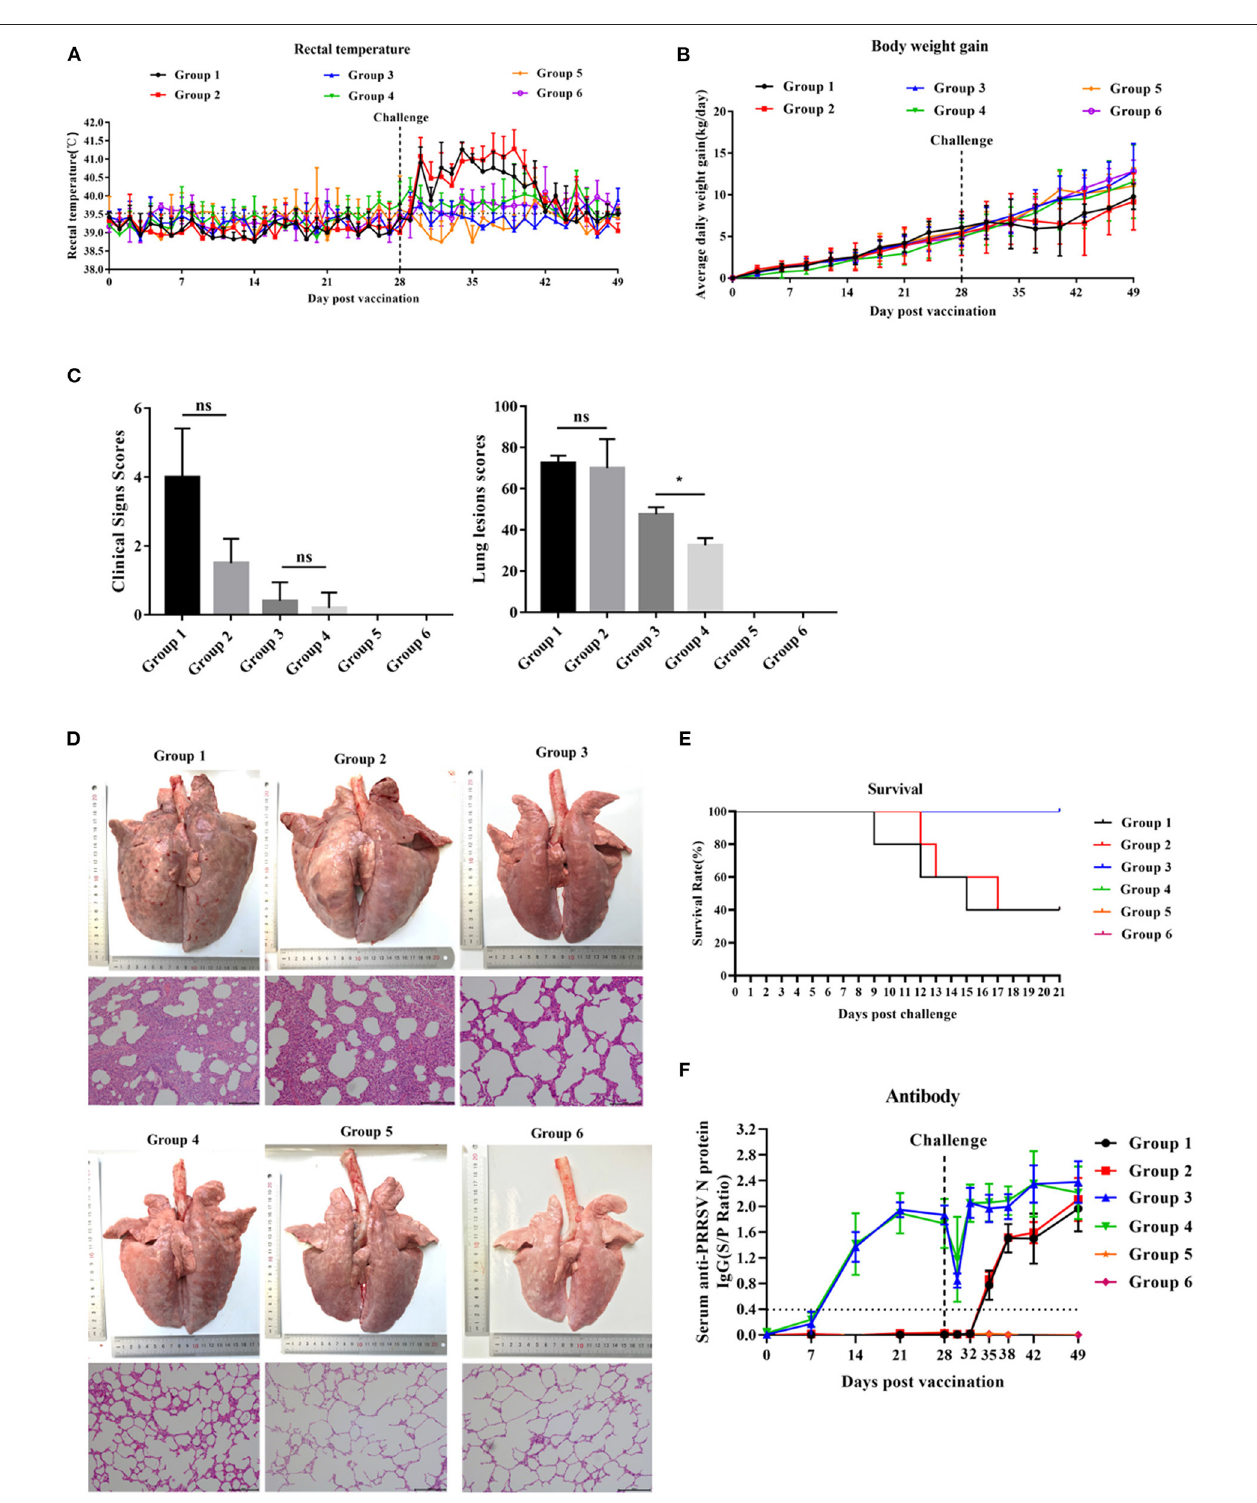
FIGURE 4 | The effect of PNS on vaccine immunity. (A) Changes in daily rectal temperature of piglets inoculated with highly virulent PRRSV JXA1. (B) The change in the weight of piglets after challenge. (C) Changes in the lungs of piglets in different groups 21 dpc. (D) The scores of clinical signs and lung lesions of piglets in different groups 21 dpc. (E) Survival curves of piglets infected with JXA1 in each group. (F) The anti-PRRSV antibody levels in serum. The S/P ratio of ≥ 0.4 was considered antibody positive. Statistical significance is denoted by * p < 0.05, ns means no significant difference.